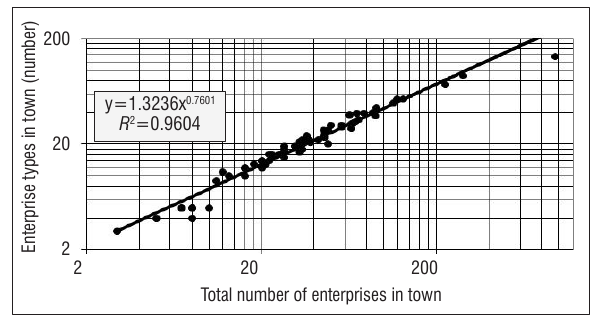
Figure 2: The relationship between the number of enterprise types (i.e. the enterprise richness) and the total number of enterprises in Free State towns and villages in 1946/1947.